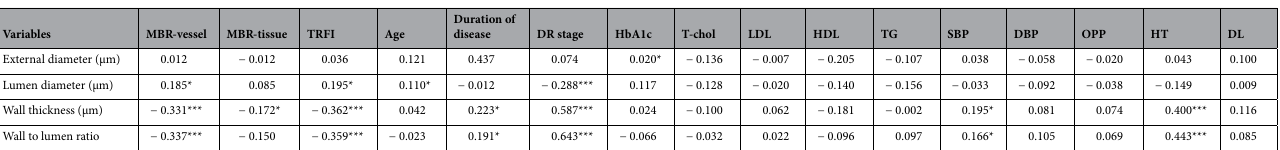
Table 4. Spearman’s rank correlation coefficient of vascular variables with other parameters. ED: external diameter; LD: lumen diameter; WT: wall thickness; WLR: wall to lumen ratio; T-chol: total cholesterol; LDL: low density lipoprotein; HDL: high density lipoprotein; TG: triglyceride; SBP: systolic blood pressure; DBP: diastolic blood pressure; OPP: ocular perfusion pressure; HT: hypertension; DL: dyslipidemia. * p < 0.05, ** p < 0.01, *** p <